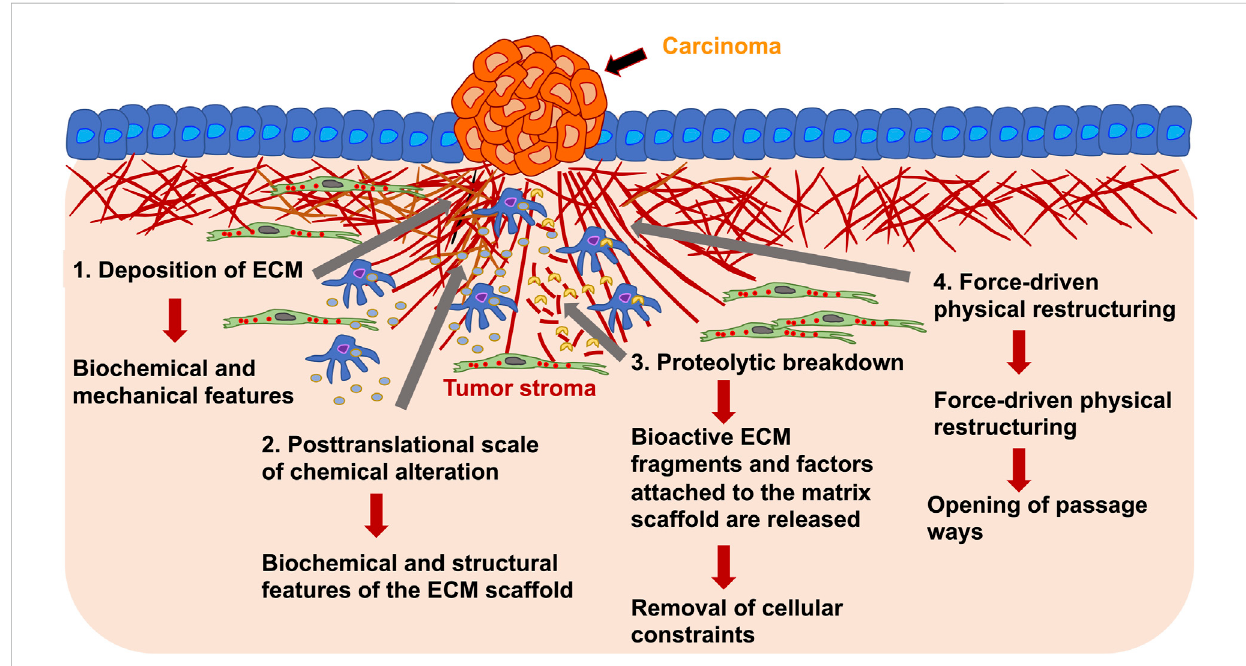
FIGURE 4 ECM remodeling of the tumor stroma around primary solid carcinomaoccurs on variouslength scales. The remodeling of thetumor stroma can be causedbycancercellsandstromaembeddedtumorassociatedcells,suchasmacrophagesand fi broblasts.Forexample,therecanbedepositionofECM molecules (1), posttranslational level of chemical alteration (2), proteolytic degradation through proteases, such as ADAM8 or MMPs (3) and force-driven physical restructuring (4). Through the ECM rearrangement are structural and mechanical characteristics affected that in turn alter the migratory capacity of cancer cells and may change the migration mode of cancer